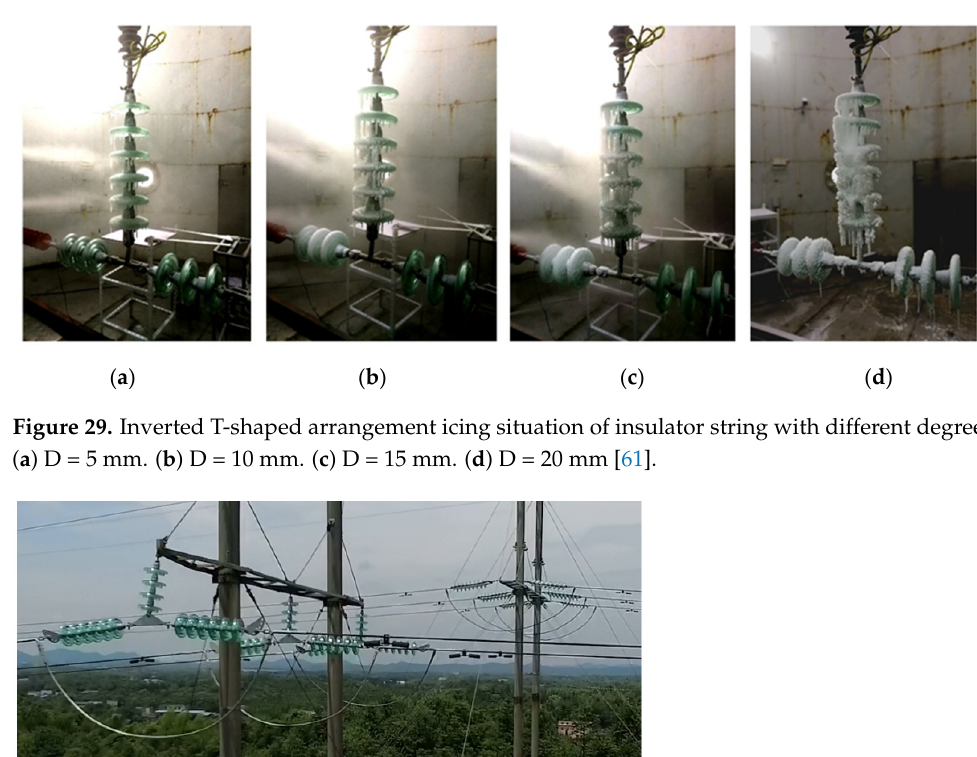
Figure 30. Application of inverted T-shaped insulator strings in transmission lines.